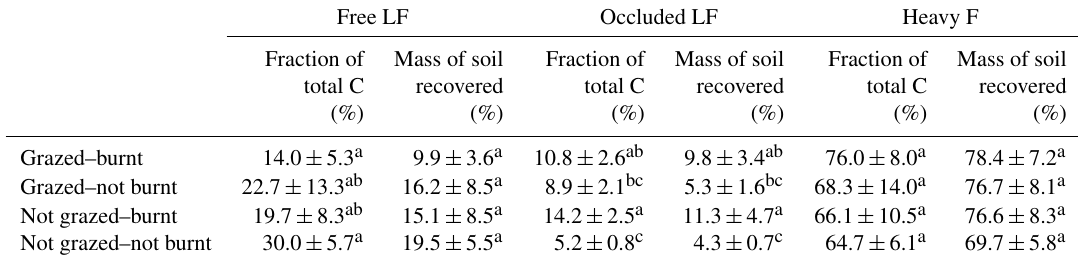
Table 4. Mean mass recovery of density fractions and proportion of total C residing in the three density fractions (%) from the total soil profile (0–30cm). Different letters down the columns represent significant